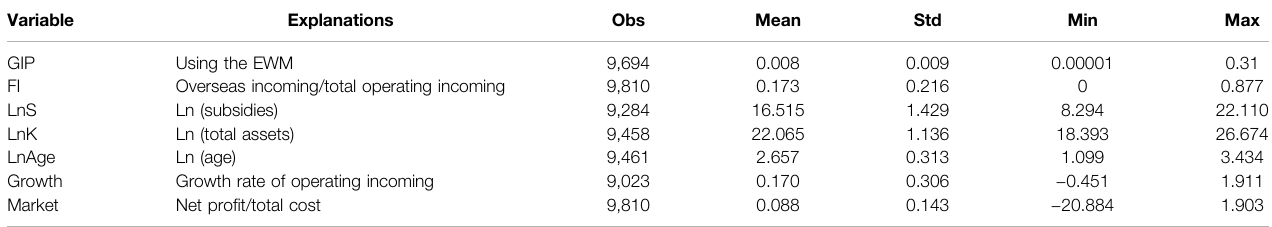
TABLE 2 | Descriptive statistics of variables.